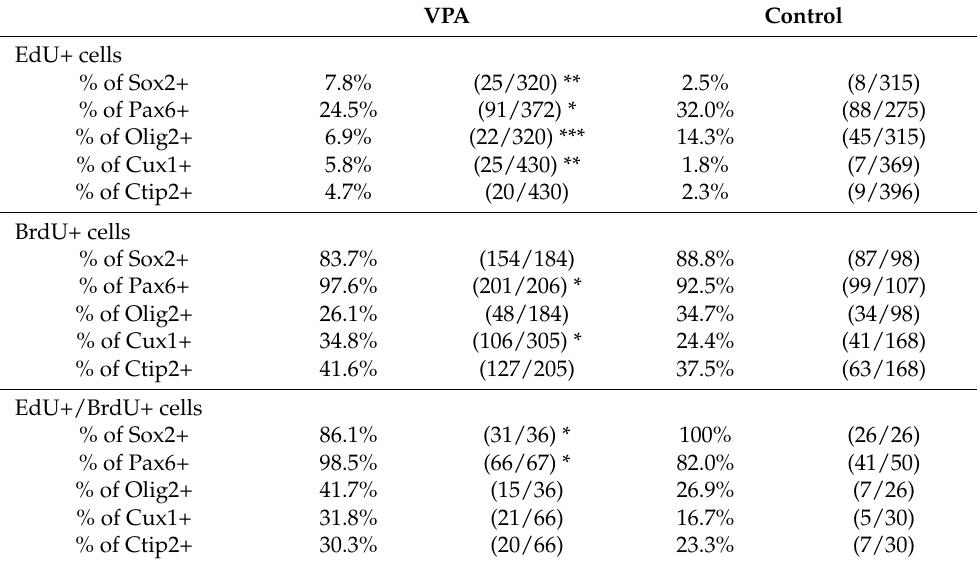
Table 1. Incidence of immunostained cells for various markers in EdU single-, BrdU single- and EdU/BrdU double-labeled cells in the subventricular zone of the premature